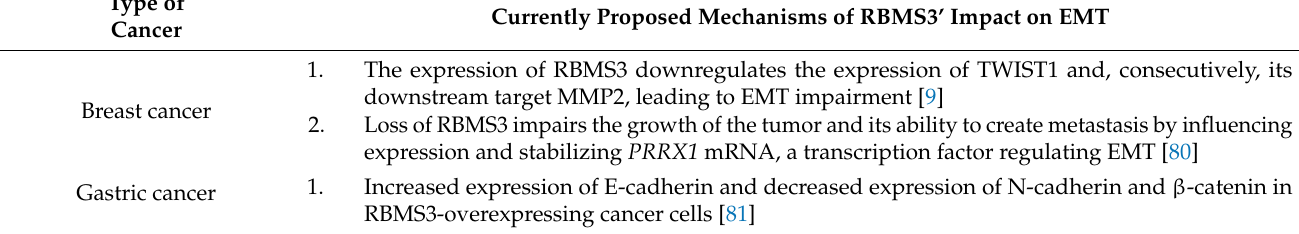
Table 3. Proposed molecular mechanisms of RBMS3’s impact on